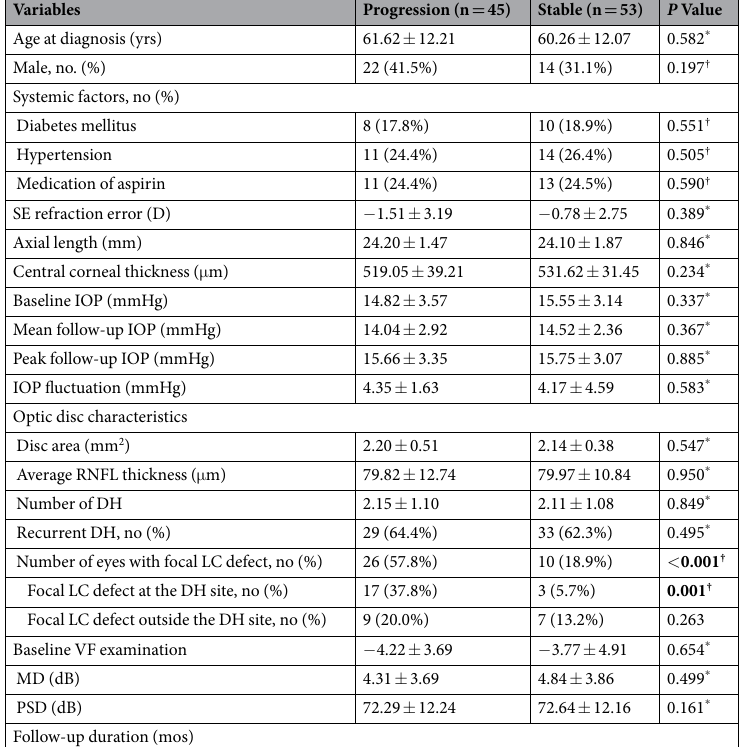
Table 2. Comparison between glaucoma patients with disc hemorrhage who showed visual field progression or remained stable during the follow-up period. D, diopters; IOP, intraocular pressure; RNFL, retinal nerve fiber layer; DH, disc hemorrhage; LC, lamina cribrosa; MD, mean deviation; PSD, pattern standard deviation; VF, visual field. * Student t-test. † Chi-square test. Data are mean ± standard deviation unless otherwise indicated. Factors with statistical significance are shown in